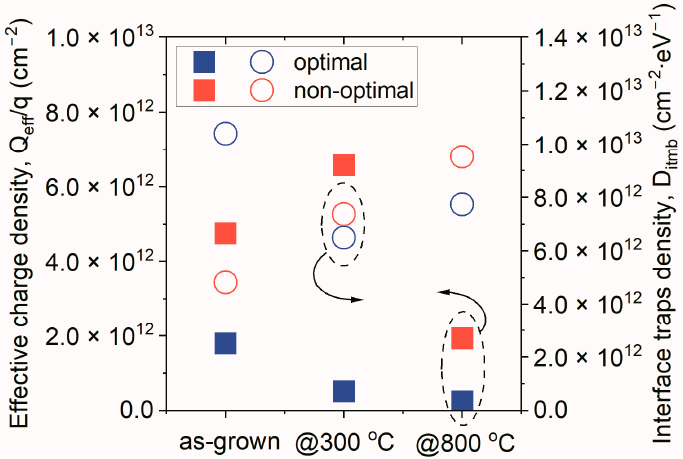
Figure 4. Q eff /q and D itmb values, estimated from analysis of C-V characteristics of MOS devices with HfO x N y , as the gate dielectric film fabricated employs optimal and non-optimal HiPIMS processes.